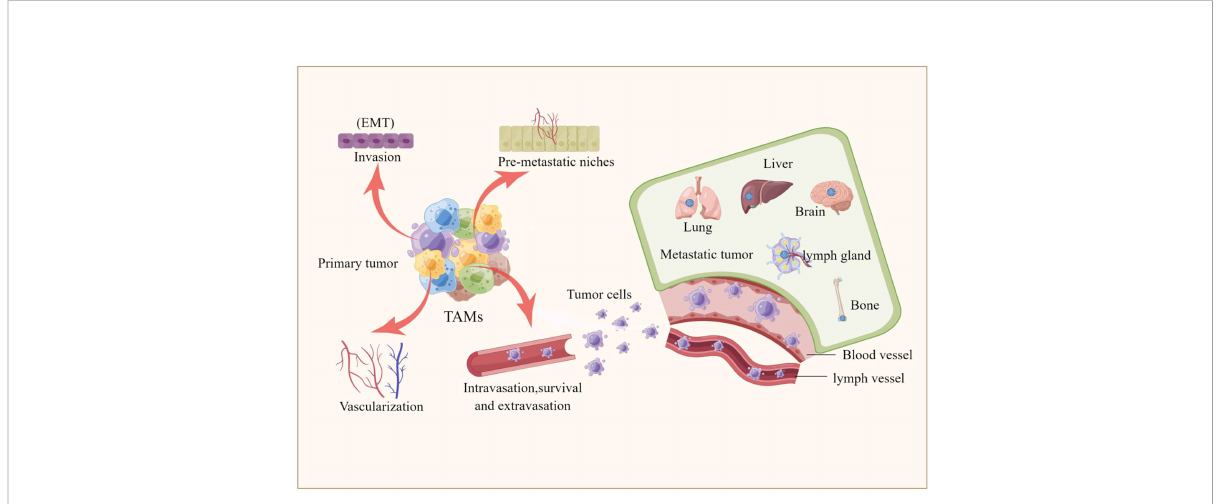
FIGURE 2 TAMs are involved tumor metastasis. The picture illustrated that TAMs are involved in every step of the metastatic cascade, including the formation of pre-metastatic ecological sites, invasion of tumor cells, survival of circulating tumor cells, extravasation and colonization of tumor cells, and the involvement of TAMs in regulating the epithelial-mesenchymal transition (EMT) process that promotes the formation of liver, brain, lung, bone and lymph node